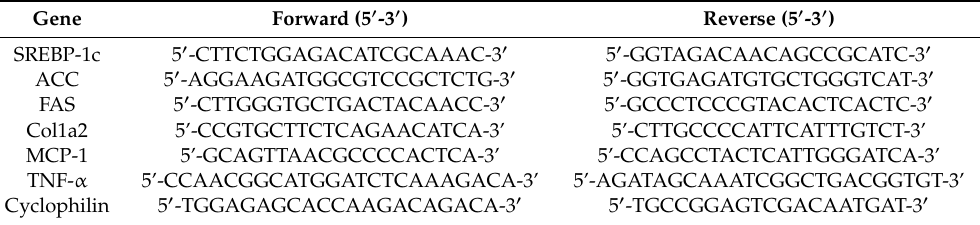
Table 1. Primer sequences for real-time